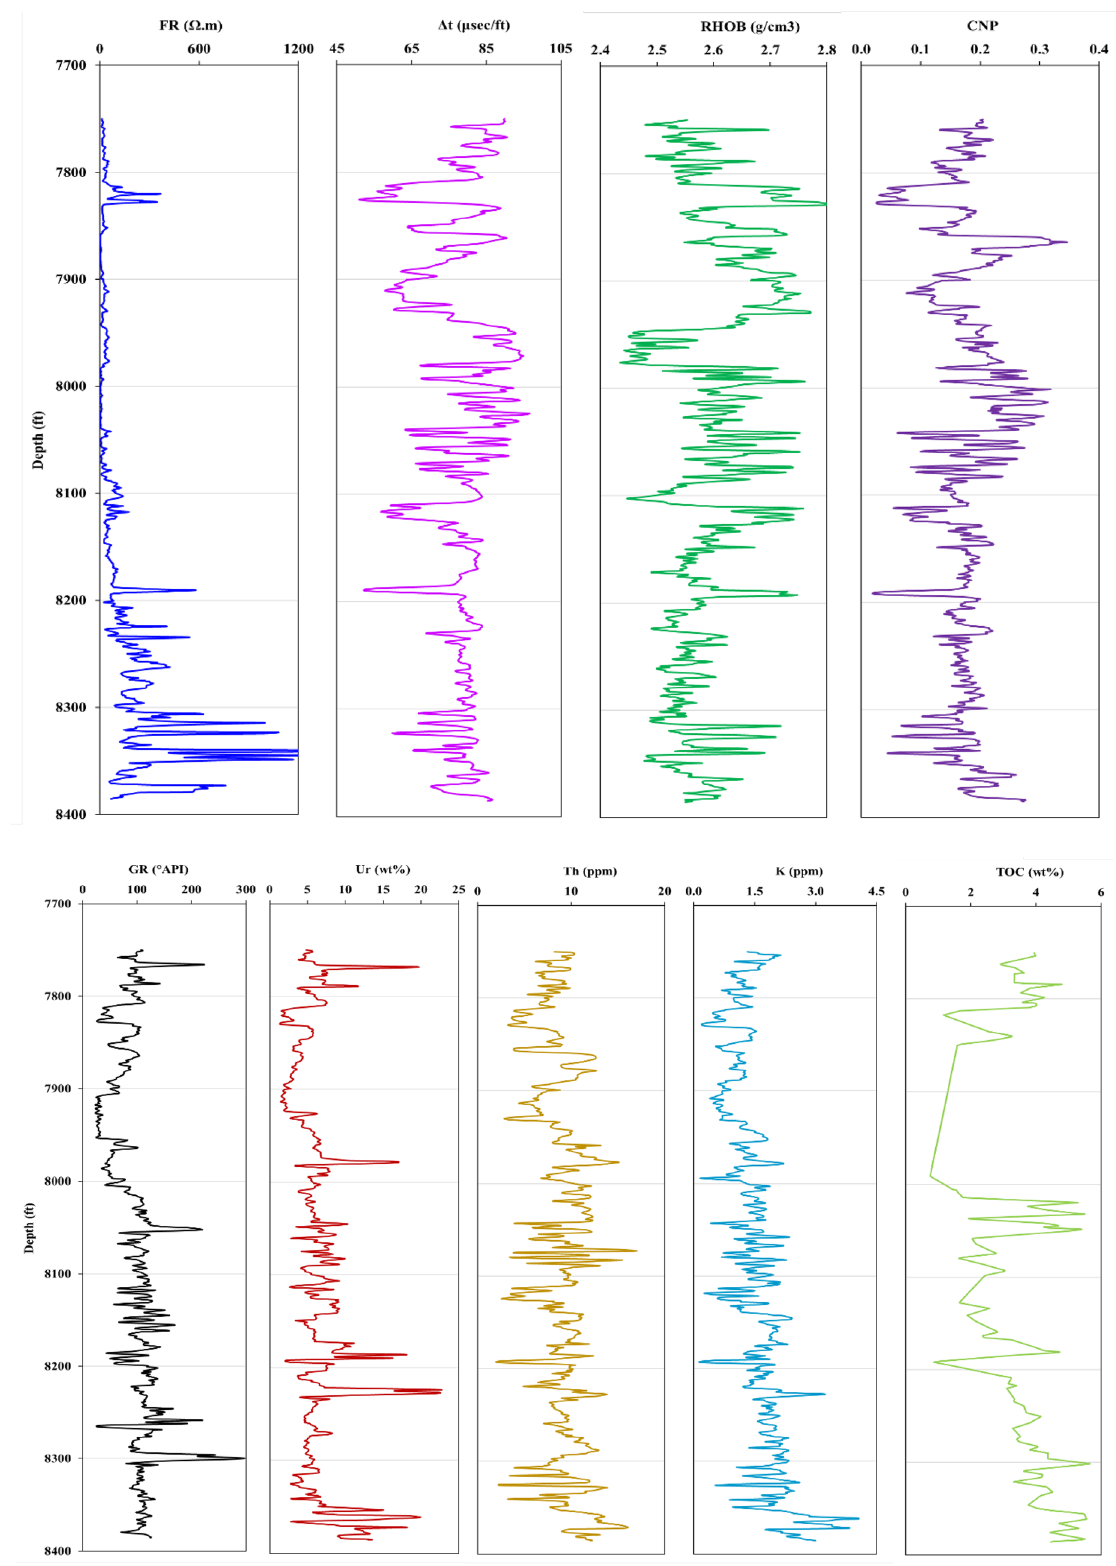
Fig. 6 The well-logs and TOC used to train the